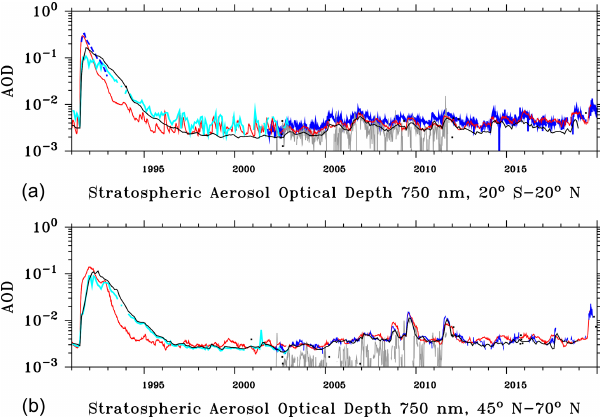
Figure 10. Stratospheric AOD at 750nm wavelength: tropical re- gions 20 ◦ S–20 ◦ N above 16km are shown in (a) and for the North- ern Hemisphere 45–70 ◦ N above 13km in (b) . Satellite observations from OSIRIS (Rieger et al., 2019) are indicated by the blue line and GOMOS (Bingen et al., 2017) by the grey line. For the Pinatubo pe- riod the dashed blue line shows the AVHRR observations by Long and Stowe (1994) at 630nm (a) . The light blue line shows the in- terpolation of SAGE data at the 525nm and 1020nm wavelengths. The EMAC model simulations, using the three-dimensional SO 2 injections of Table 2, are shown by the red line. The black line represents GloSSAC, derived from extinction at 525 and 1020nm. EMAC, GOMOS, and OSIRIS as 5d averages, other data